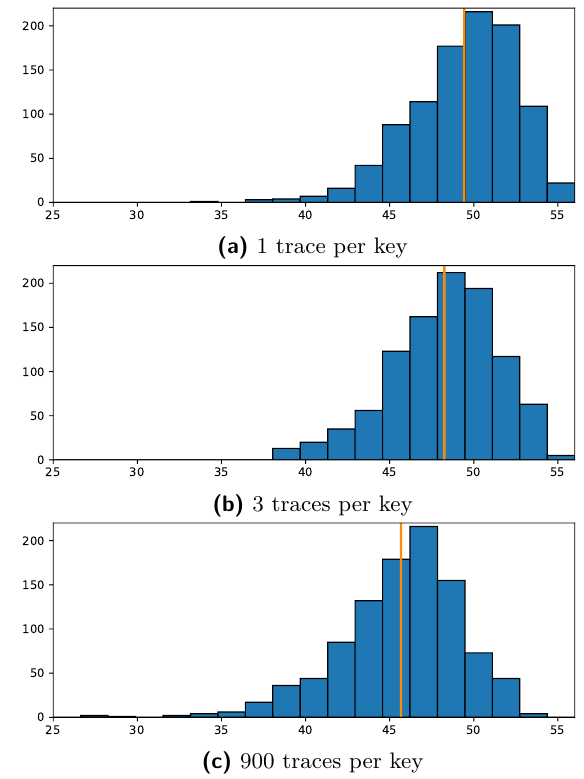
Figure 14: Histograms of security levels after template attacks on 1000 keys. Security levels are plotted on the x-axis, number of keys per bin on the y-axis. Results are shown for 300 POIs and three different numbers of attack traces (1,3 and 900) per key. The mean security level is marked by an orange